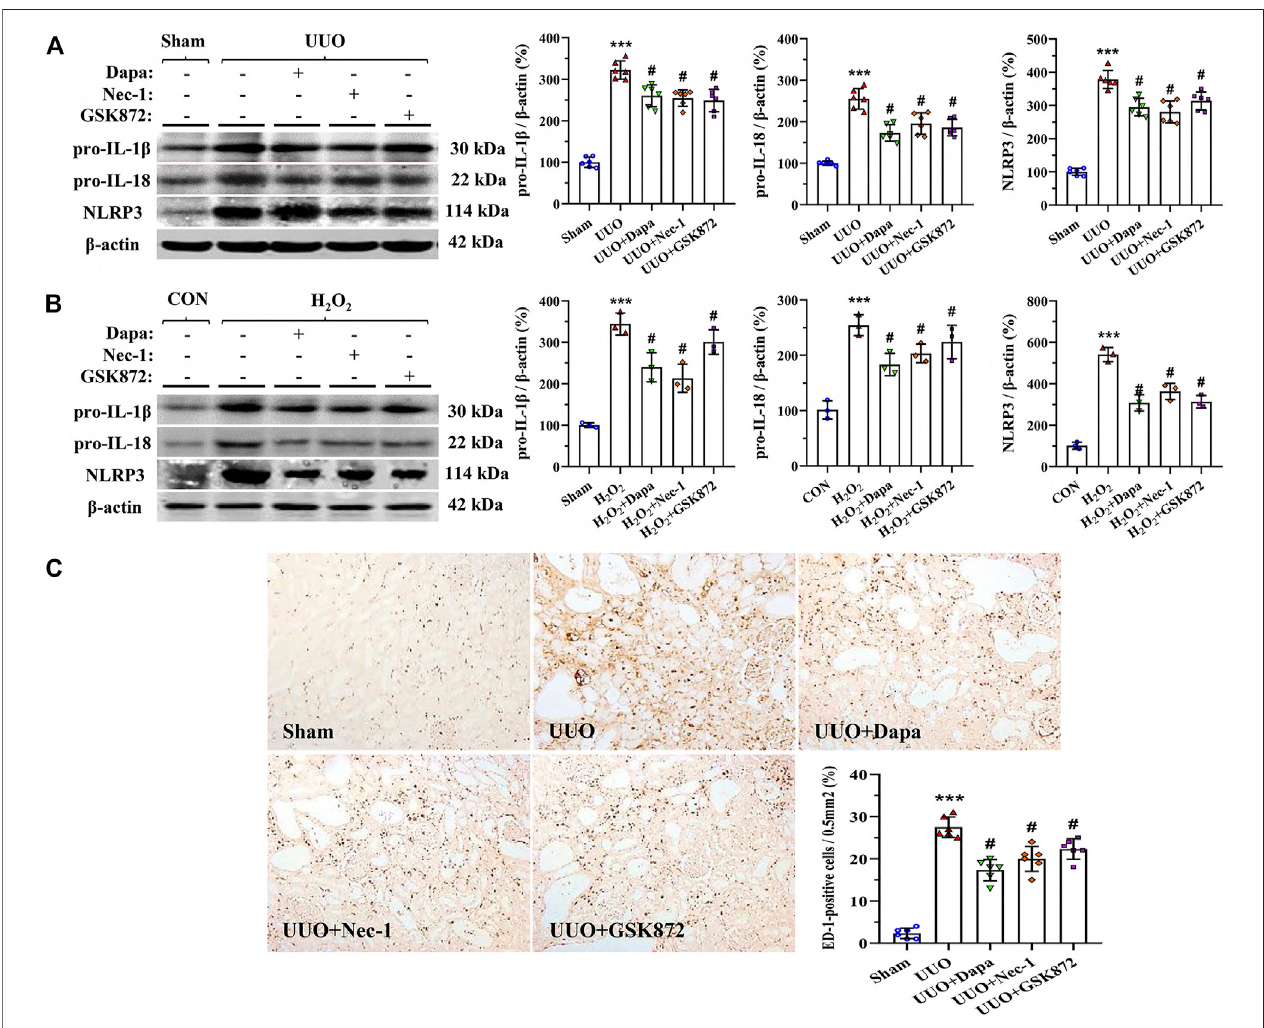
FIGURE 2 | Representative photomicrographs of immunoblotting analysis of a series of pyroptosis-related proteins in vivo (A) and in vitro (B) and immunohistochemistry for ED-1 (C) . Data are presented as mean ± SEM ( in vivo , n (cid:2) 6; in vitro , n (cid:2) 3) and analyzed by one-way ANOVA. *** p < 0.01 vs sham or control; # p < 0.05 vs UUO or H 2 O 2